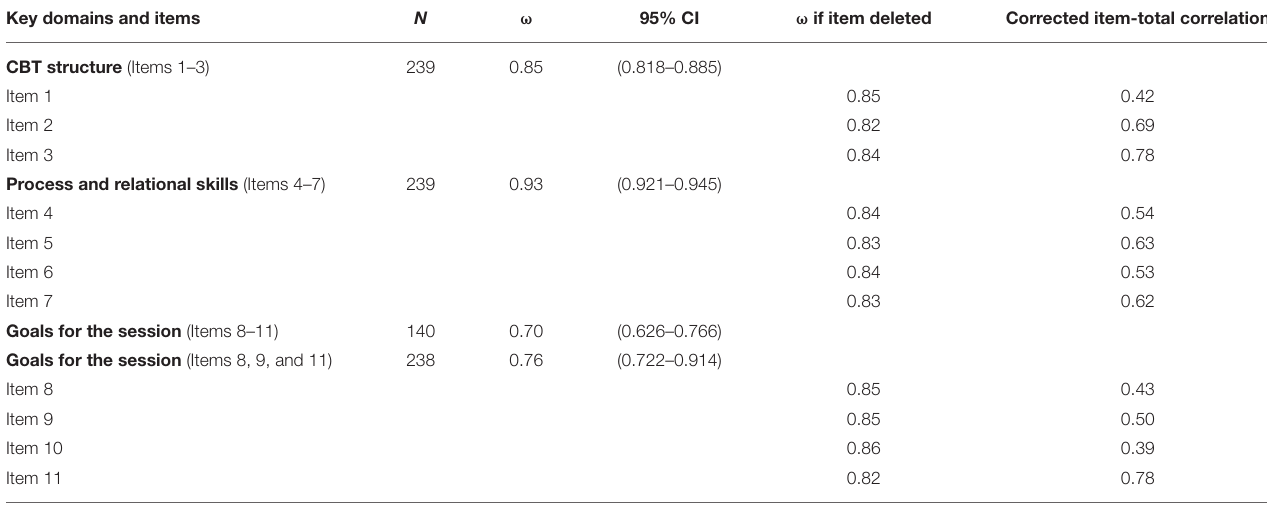
TABLE 3 | Omega coefficients of the CAS-CBT.